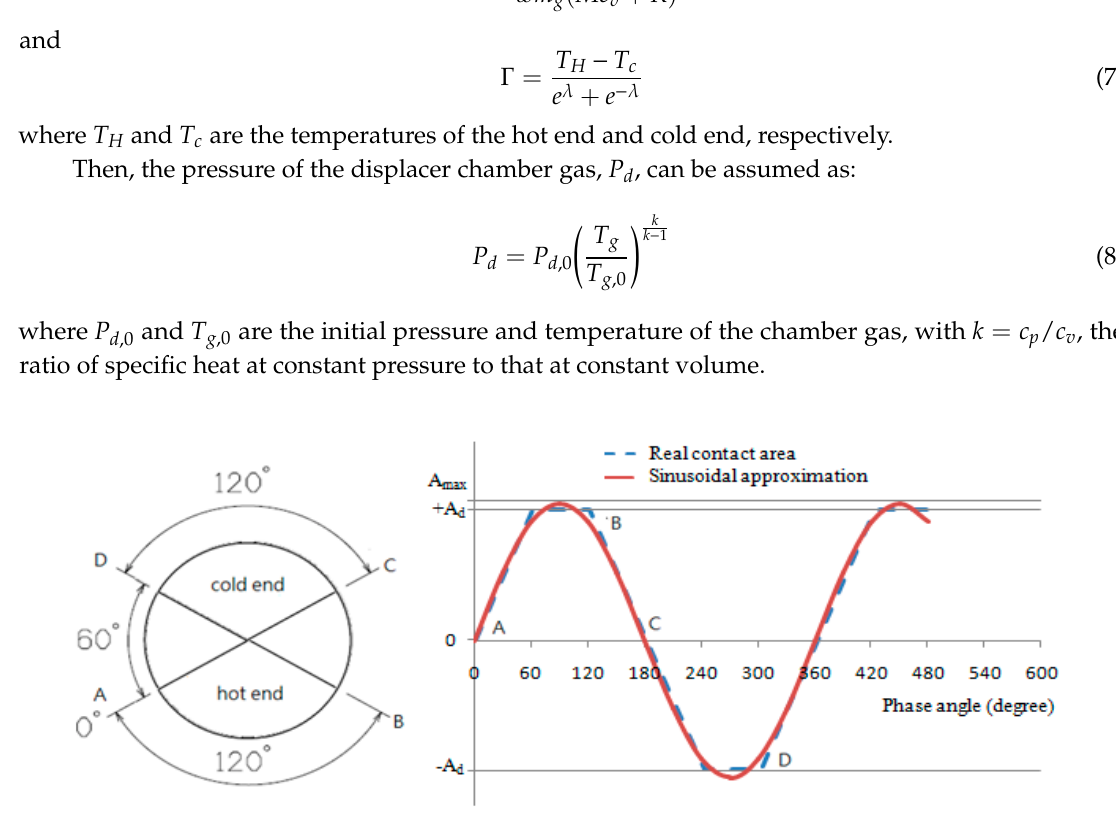
Figure 6. Sinusoidal approximation of the real contact surface area of the displacer gas.